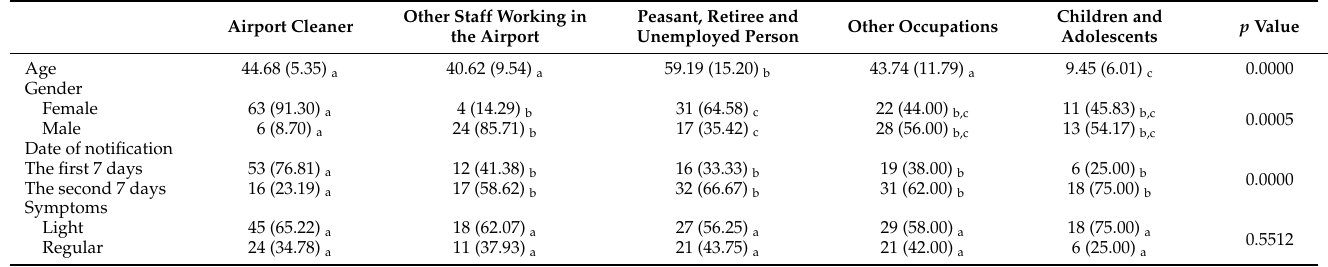
Table 2. Basic Characteristics of Confirmed Cases Categorized by Occupation in Nanjing.